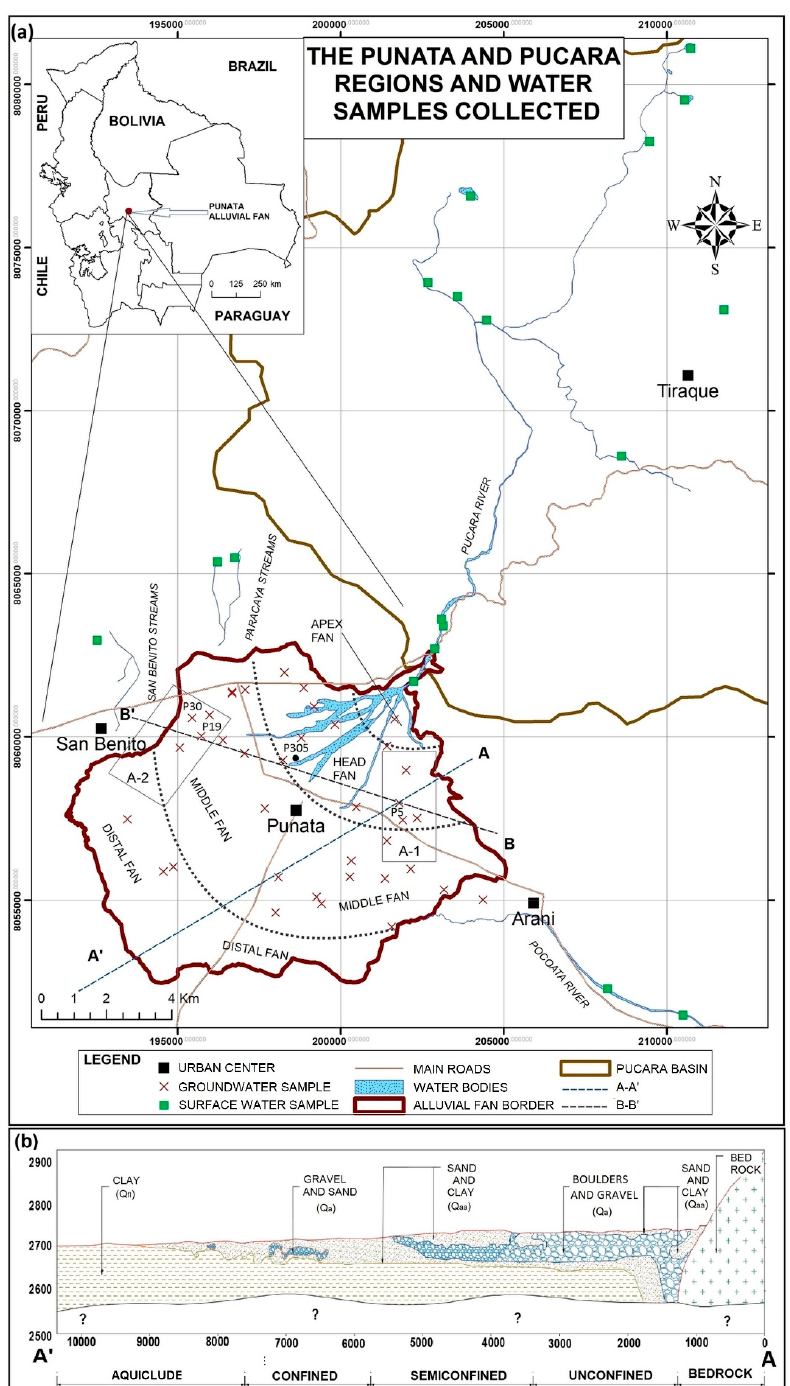
Figure 1. ( a ) Study area and location of water samples. The water samples are classified in surface water and groundwater; ( b ) Cross section of the Punata alluvial fan, where the question mark means that the depth to bedrock is still unknown, from Gonzales Amaya, et al. [15].